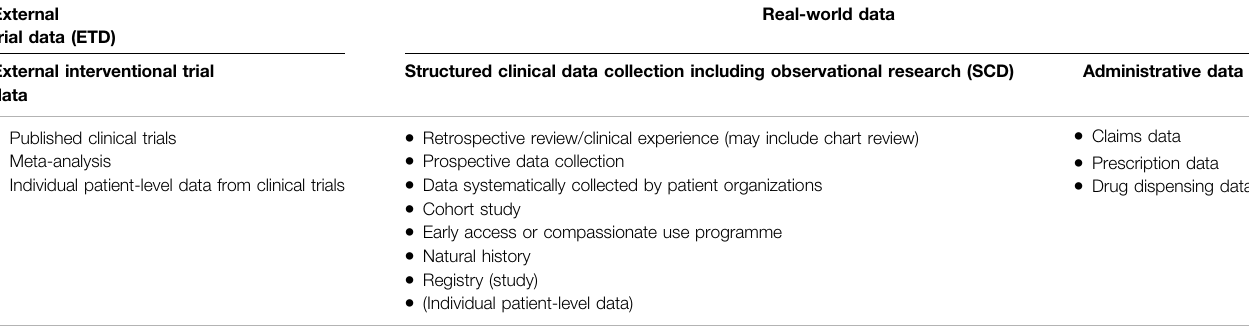
TABLE 1 | De fi nition of classi fi cation of external data described in EPARs, OMARs, and Annex II D. External trial data